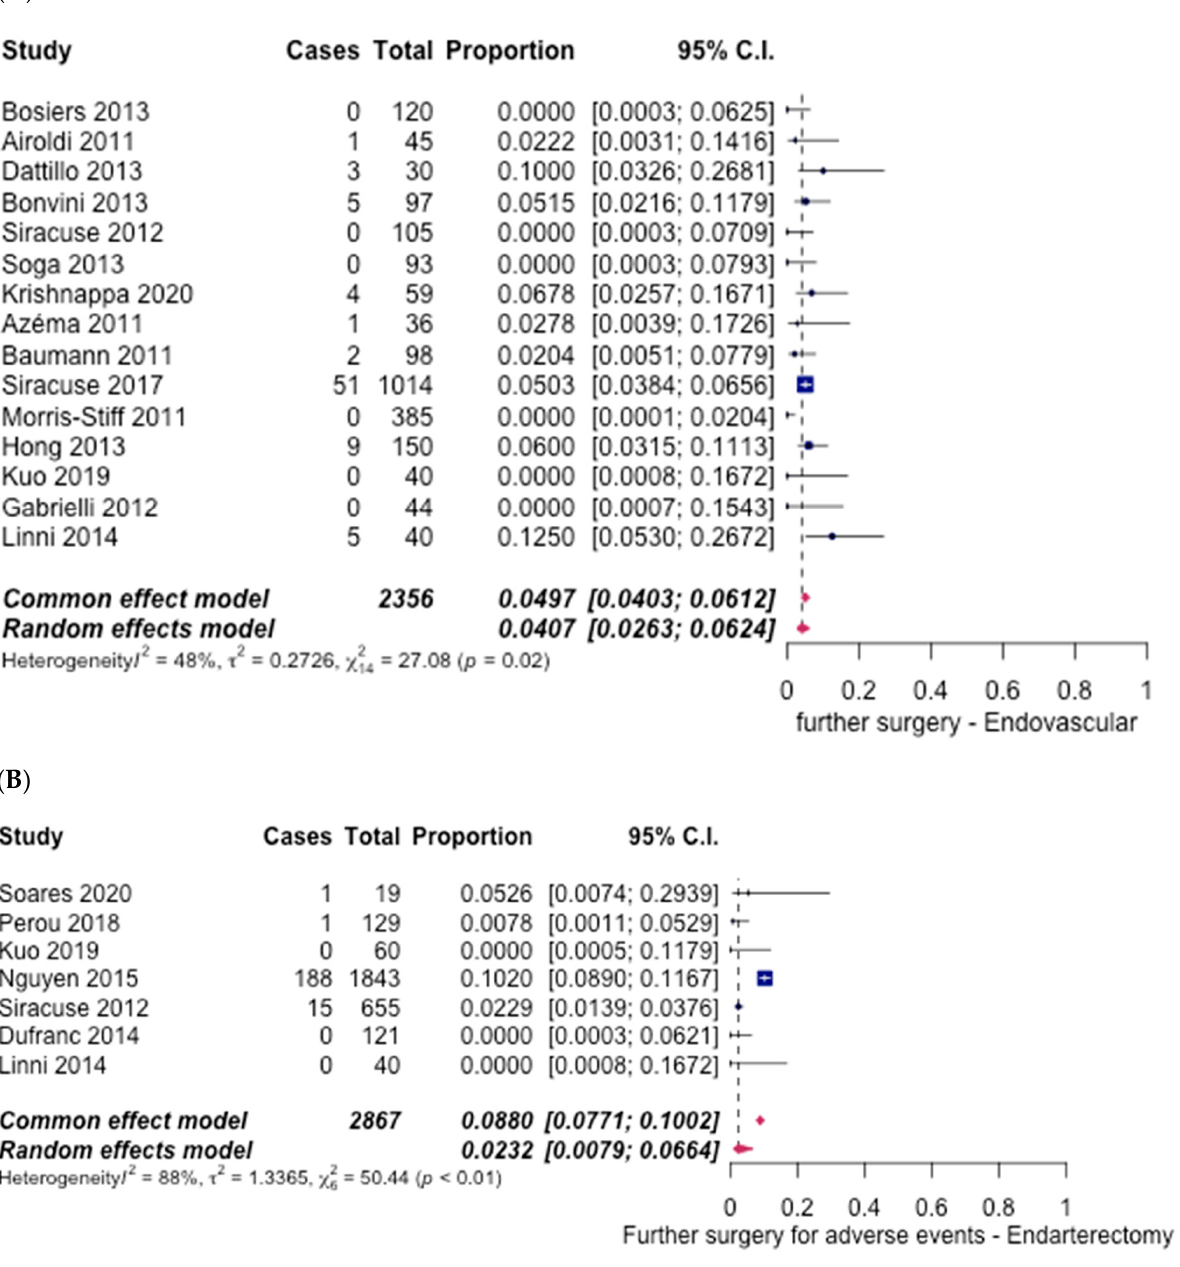
Figure 16. Forest plot for further surgery for adverse events. ( A ) Endovascular intervention [6–12,15–21]. ( B ) Endarterectomy [6,21–25,29].